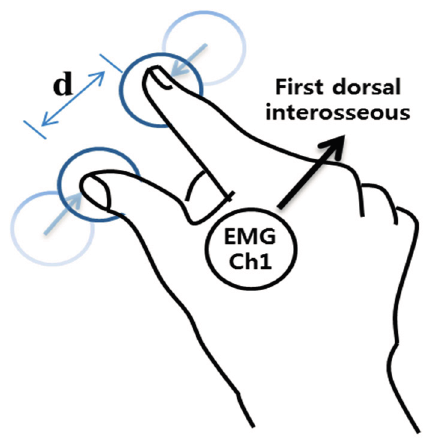
Figure 1. Scheme for pinch-to-zoom gesture. sEMG signal which is highly related to the pinch-to-zoom gesture is obtained from first dorsal interosseous muscle. In this figure, d means the distance between thumb and index